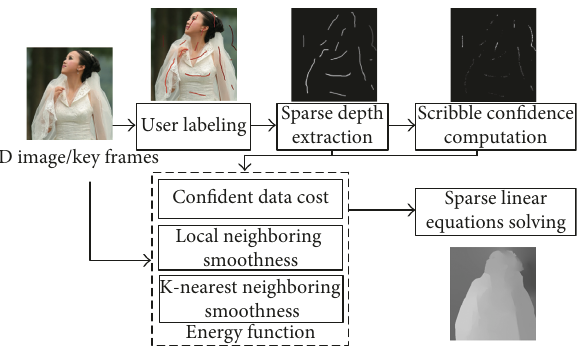
Figure 2: The flowchart of the proposed